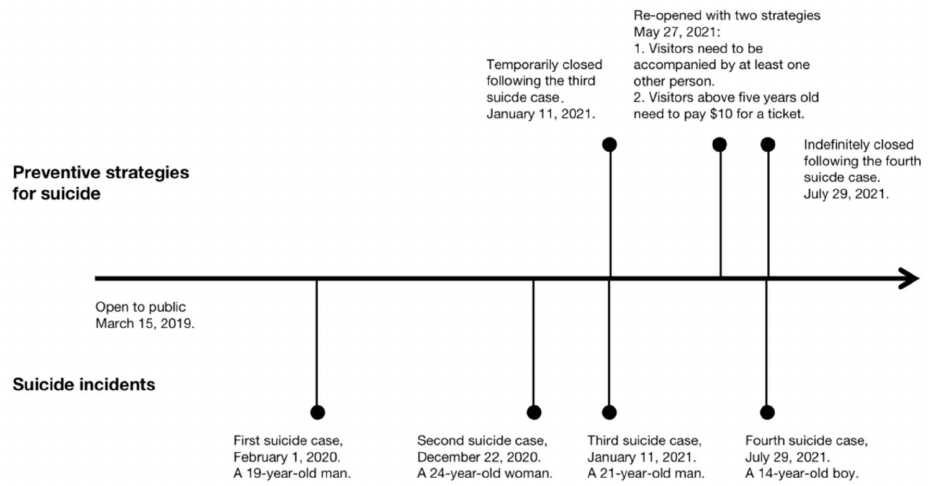
Figure 2. Timeline of suicide incidents at Vessel and the preventative strategies that followed (as of August